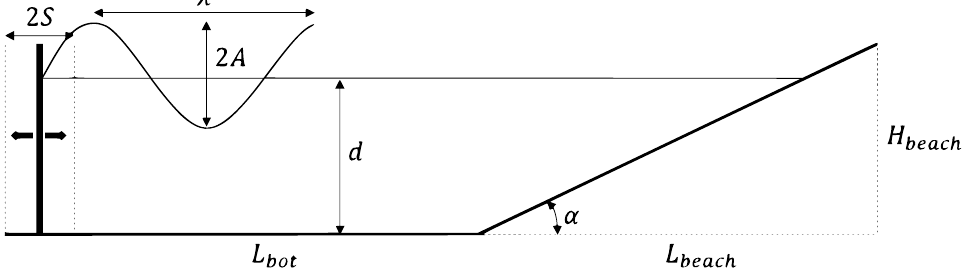
Figure 1. Water basin setup for wave